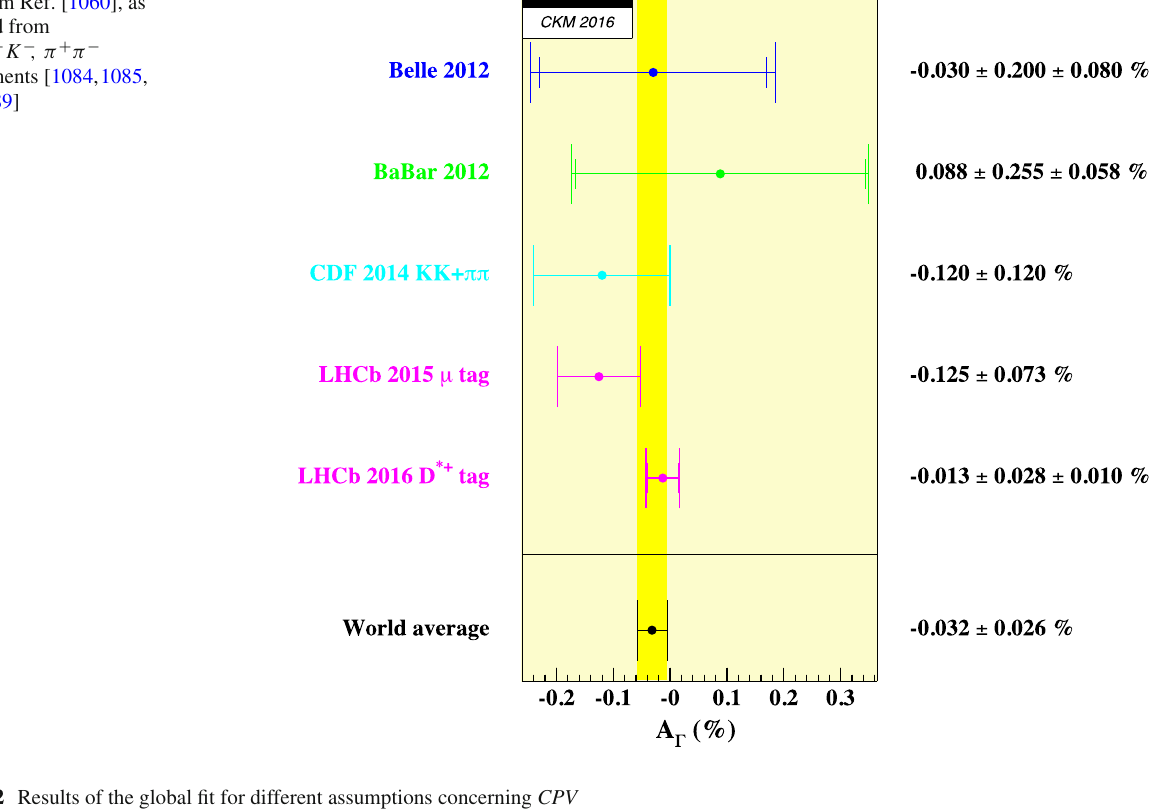
Fig. 193 World average value of A (cid:6) from Ref. [1060], as